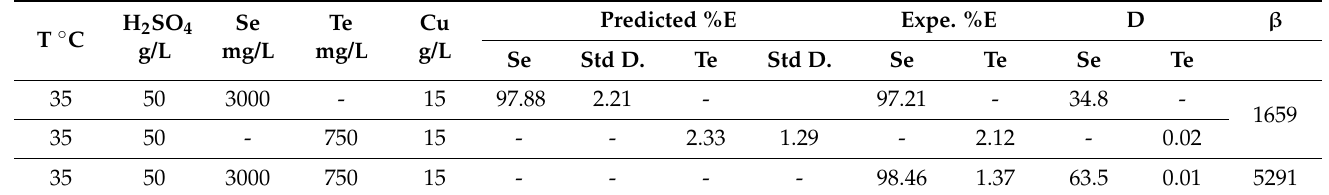
Table 6. Experiments for models’ validations of Se and Te